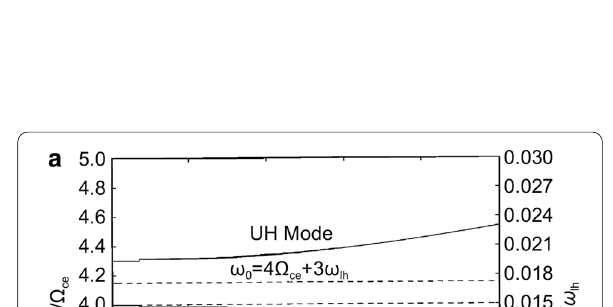
and satellite PRN 07, show the similar temporal evolution